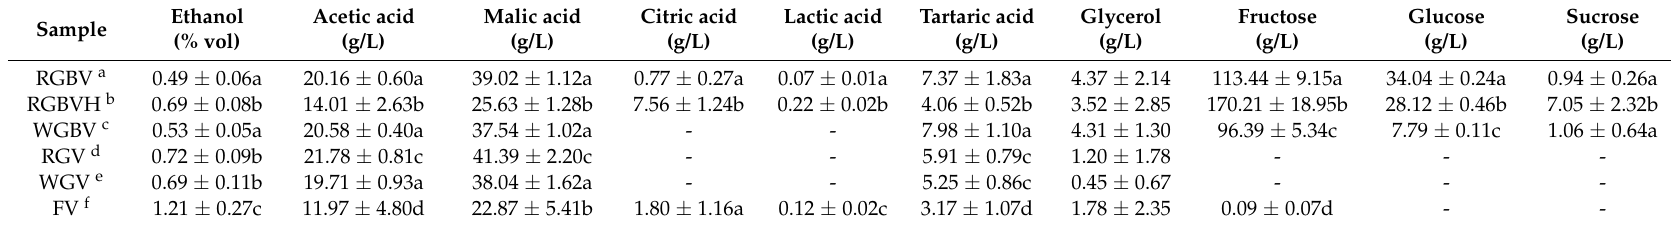
Table 5. Vinegars’ organic acid and sugar